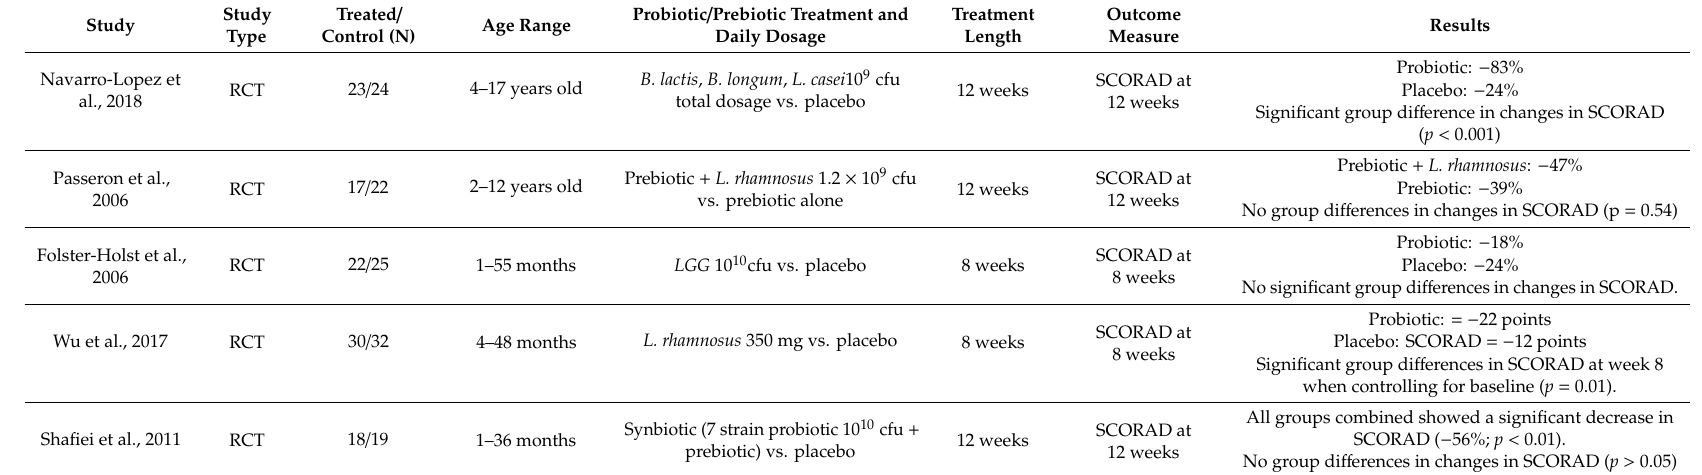
Synbiotic (7 strain probiotic 10 10 cfu + prebiotic) vs. placebo